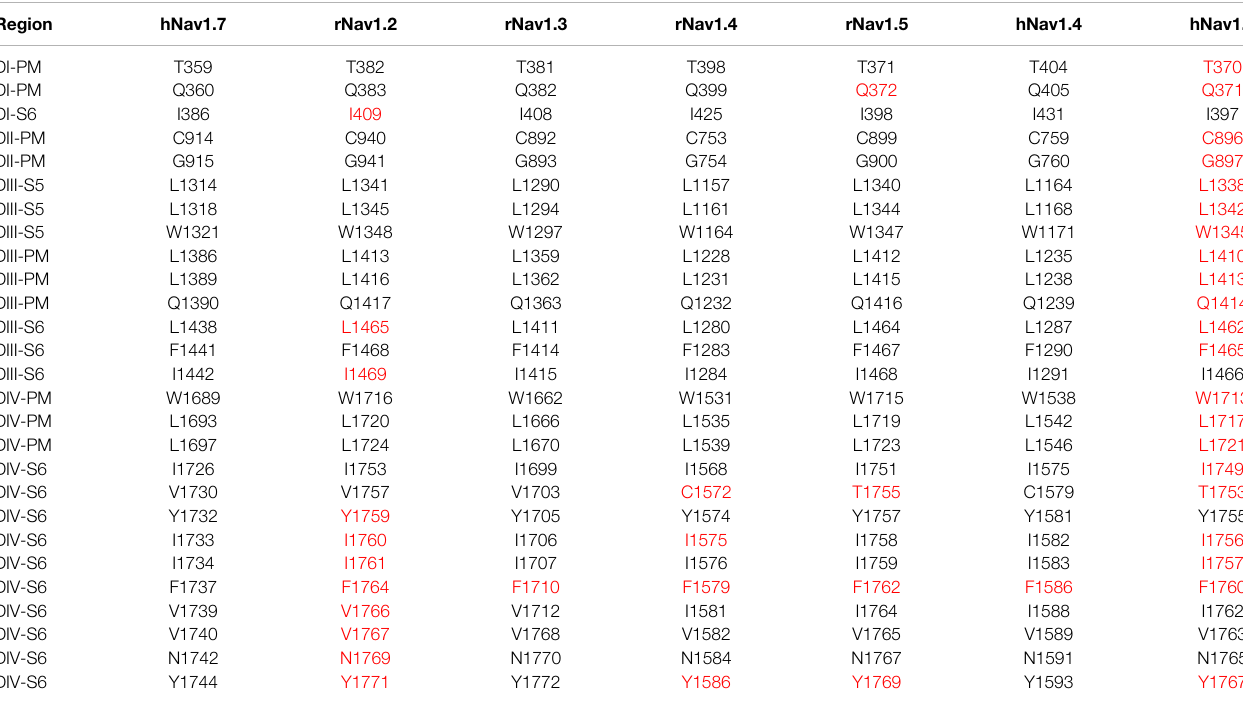
TABLE 2| Mappingoftheresidues involvedinLAbindingofdifferenteukaryoticNavsubtypes(isoforms1)discussedin Section5 tothehumanNav1.7(isoform3).Multiple sequence alignment was performed using the T-Coffee package provided by JABAWS (Troshin et al., 2011). A red color is used to highlight the residues mentioned in Section 5 . r represents rats and h humans. The mapping of the residues to the respective regions in the protein are based on the topology of hNav1.7 given in Uniprot (Uniprot ID: Q15858). DI-DIV represent the four domains, S1 — S6 represent the six transmembrane segments for each domain, and PM represents the pore module that forms the